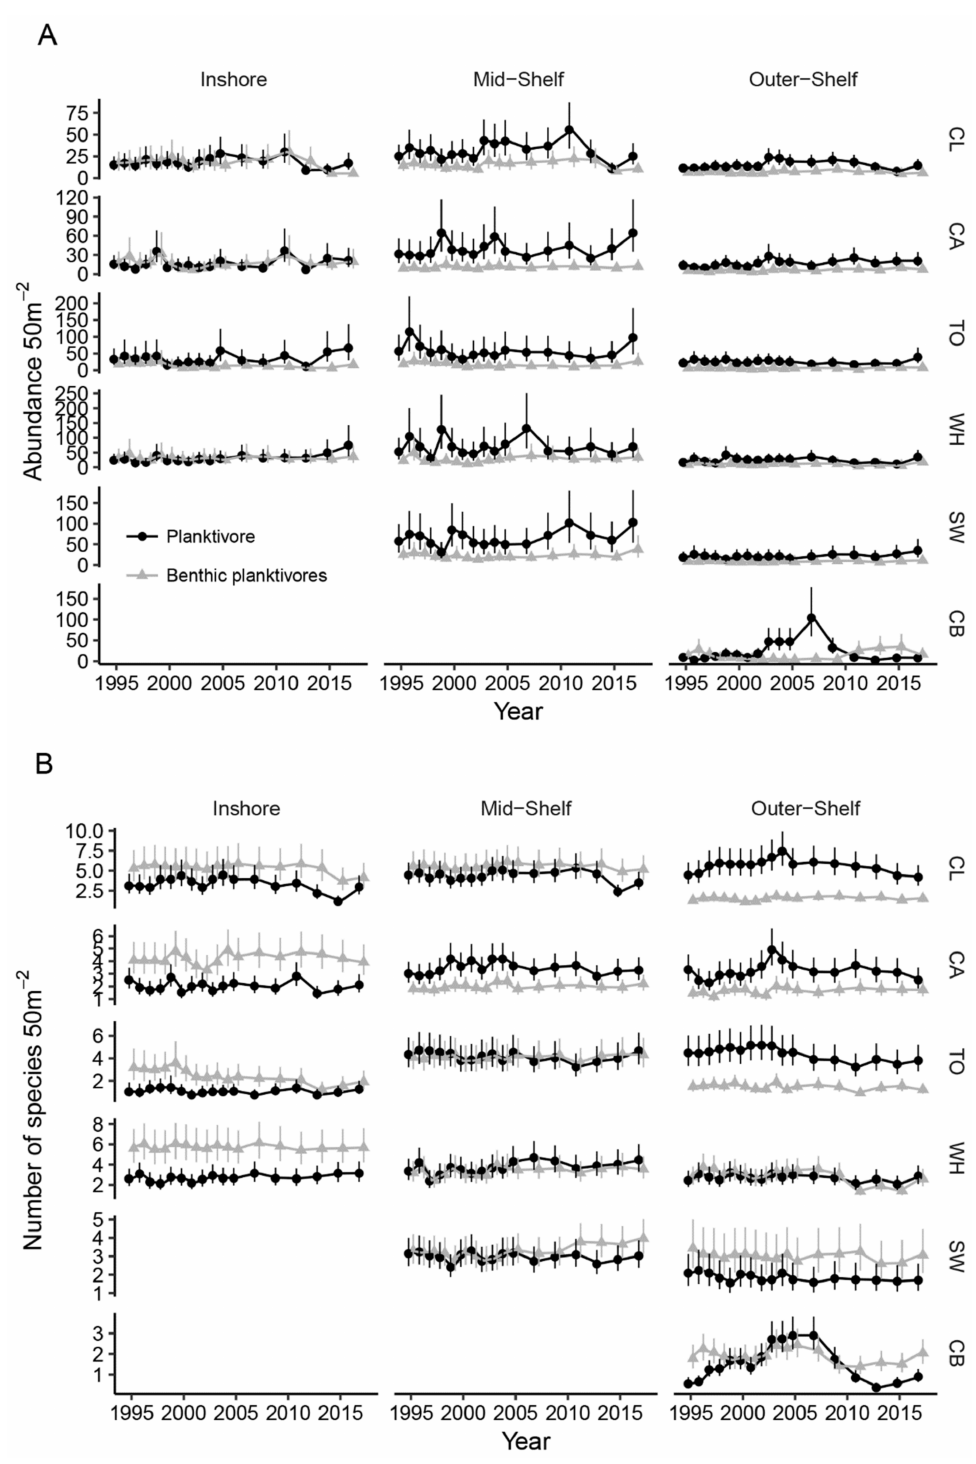
Figure 4. Temporal patterns in the ( A ) density and ( B ) species richness of planktivorous damselfishes on the Great Barrier Reef. Data are modelled higher posterior distribution means and associated 95% uncertainty intervals (UIs) from Bayesian hierarchical linear mixed models. Statistical differences among sub-regions can be inferred where 95% UIs do not overlap. Latitudinal sectors are CL Cooktown-Lizard Island, CA Cairns, TO Townsville, WH Whitsunday, SW Swain, CB